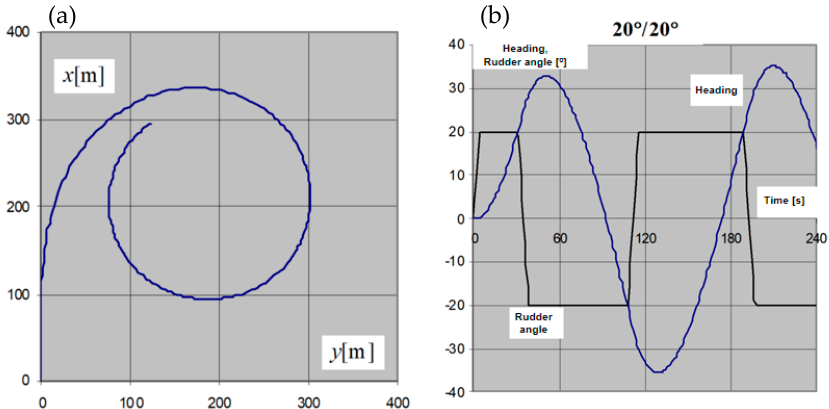
Figure 3. Selected results from model trials: ( a ) turning circle and ( b ) 20°-20° Zig-Zag manoeuvre.